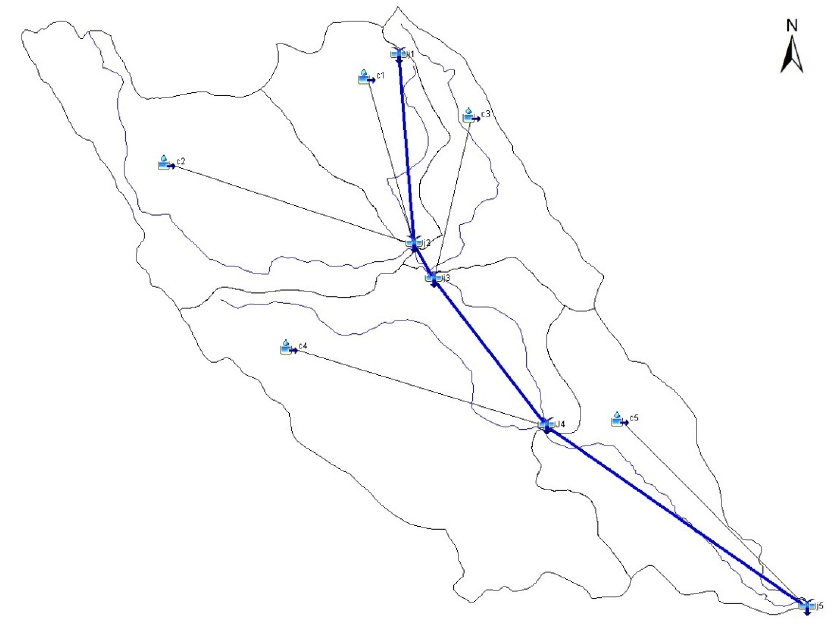
Figure 8. HEC-HMS model for the Wirynka catchment area.